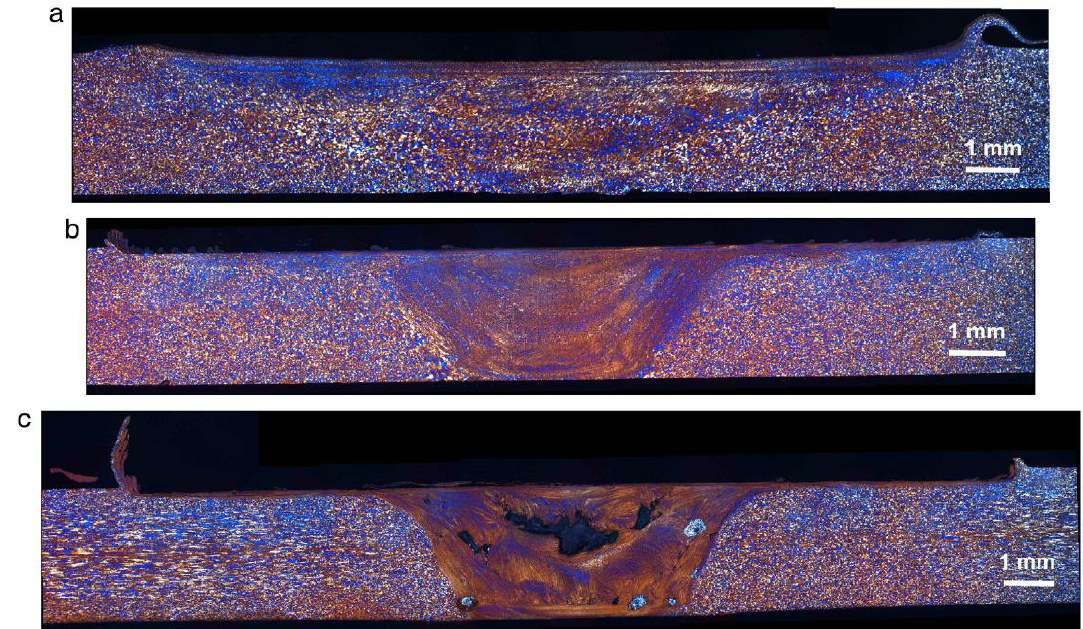
Figure 11. Montage of polarized optical microscopy (POM) of joints in as-received AA5754 alloy obtained by performing FSW at: ( a ) R = 0 mm, ( b ) R = 0.5 mm and ( c ) R = 1 mm.